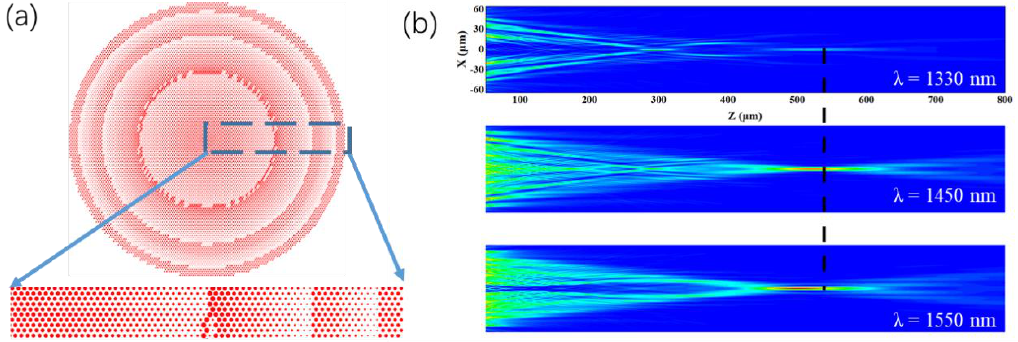
Figure 4. ( a ) The nanostructured layout of the designed achromatic lens; ( b ) the lateral optical intensity distributions at 1330 nm, 1450 nm, and 1550 nm.